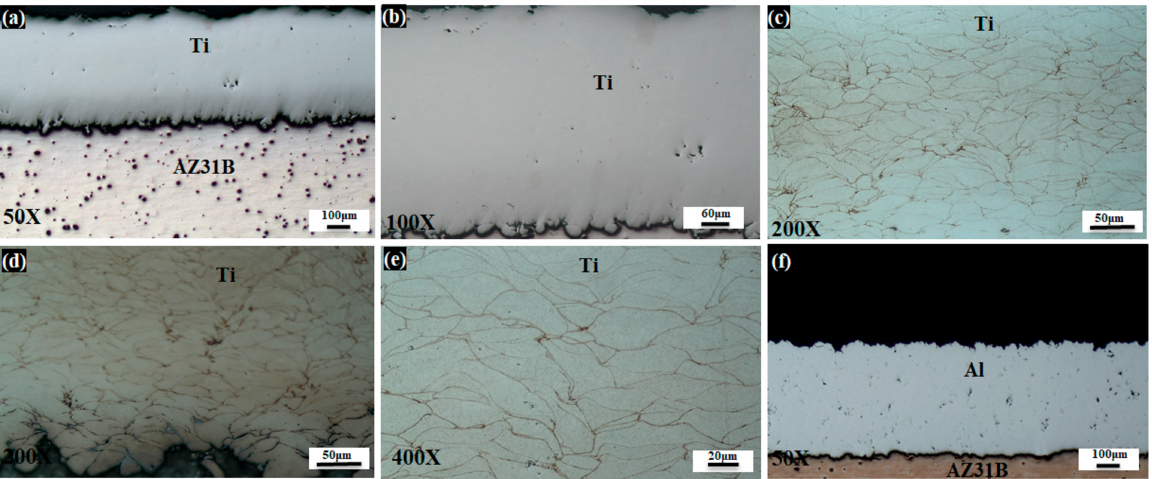
Figure 2. SEM images from ( a ) cross section of Ti-coated AZ31B, ( b ) Ti coating surface, ( c ) cross section of Al-coated AZ31B, ( d ) Al coating surface, EDS analysis of 1 ( e ), 2 ( f ), and EDS analysis of 3 ( g ), 4 ( h ).